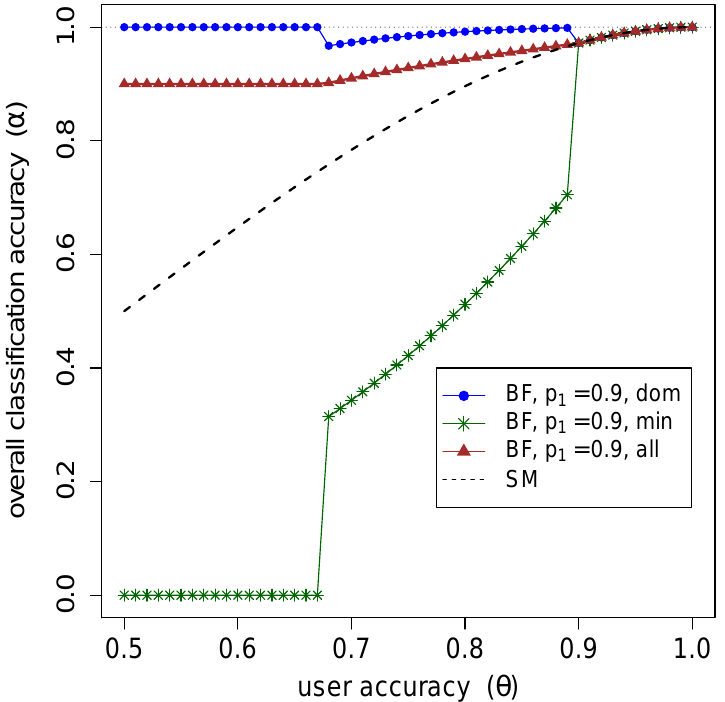
Figure 1. The overall classification accuracy α of the Simple Majority (SM) and Bayes Formula (BF) for the dominant and minority classes and overall as the function of user accuracy θ (assumed fully known) for p 1 = 0.9. BF performs better than SM on average by better identifying the dominant class at the cost of misidentifying the minority